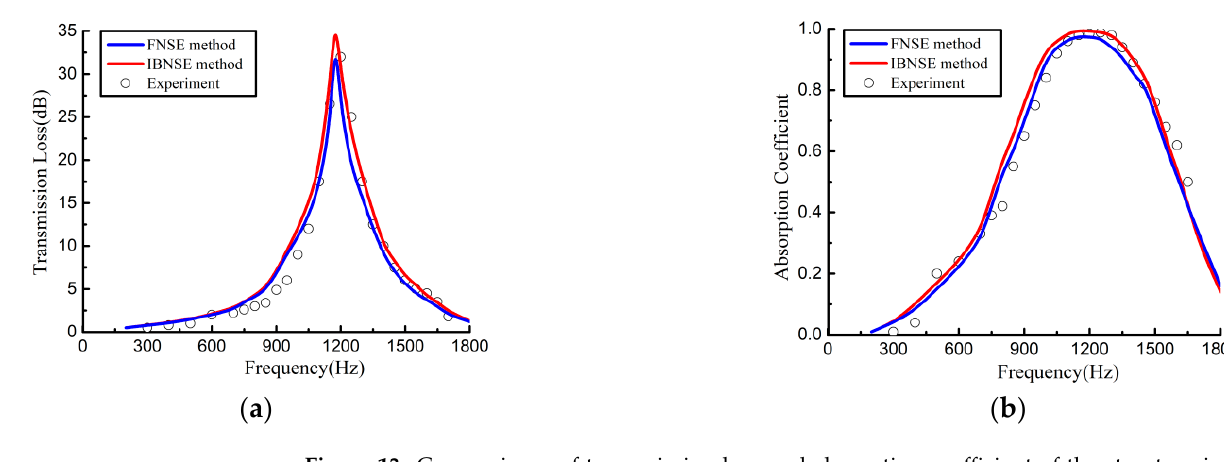
Figure 13. Comparisons of transmission loss and absorption coefficient of the structure in Reference [15]. ( a ) Transmission loss and ( b ) acoustic absorption coefficient.